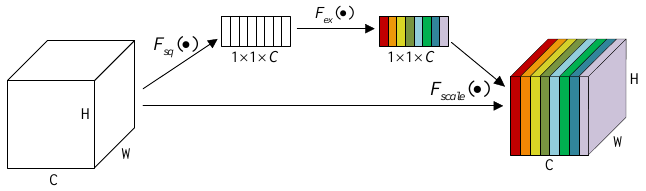
Figure 3. The structure diagram of channel attention